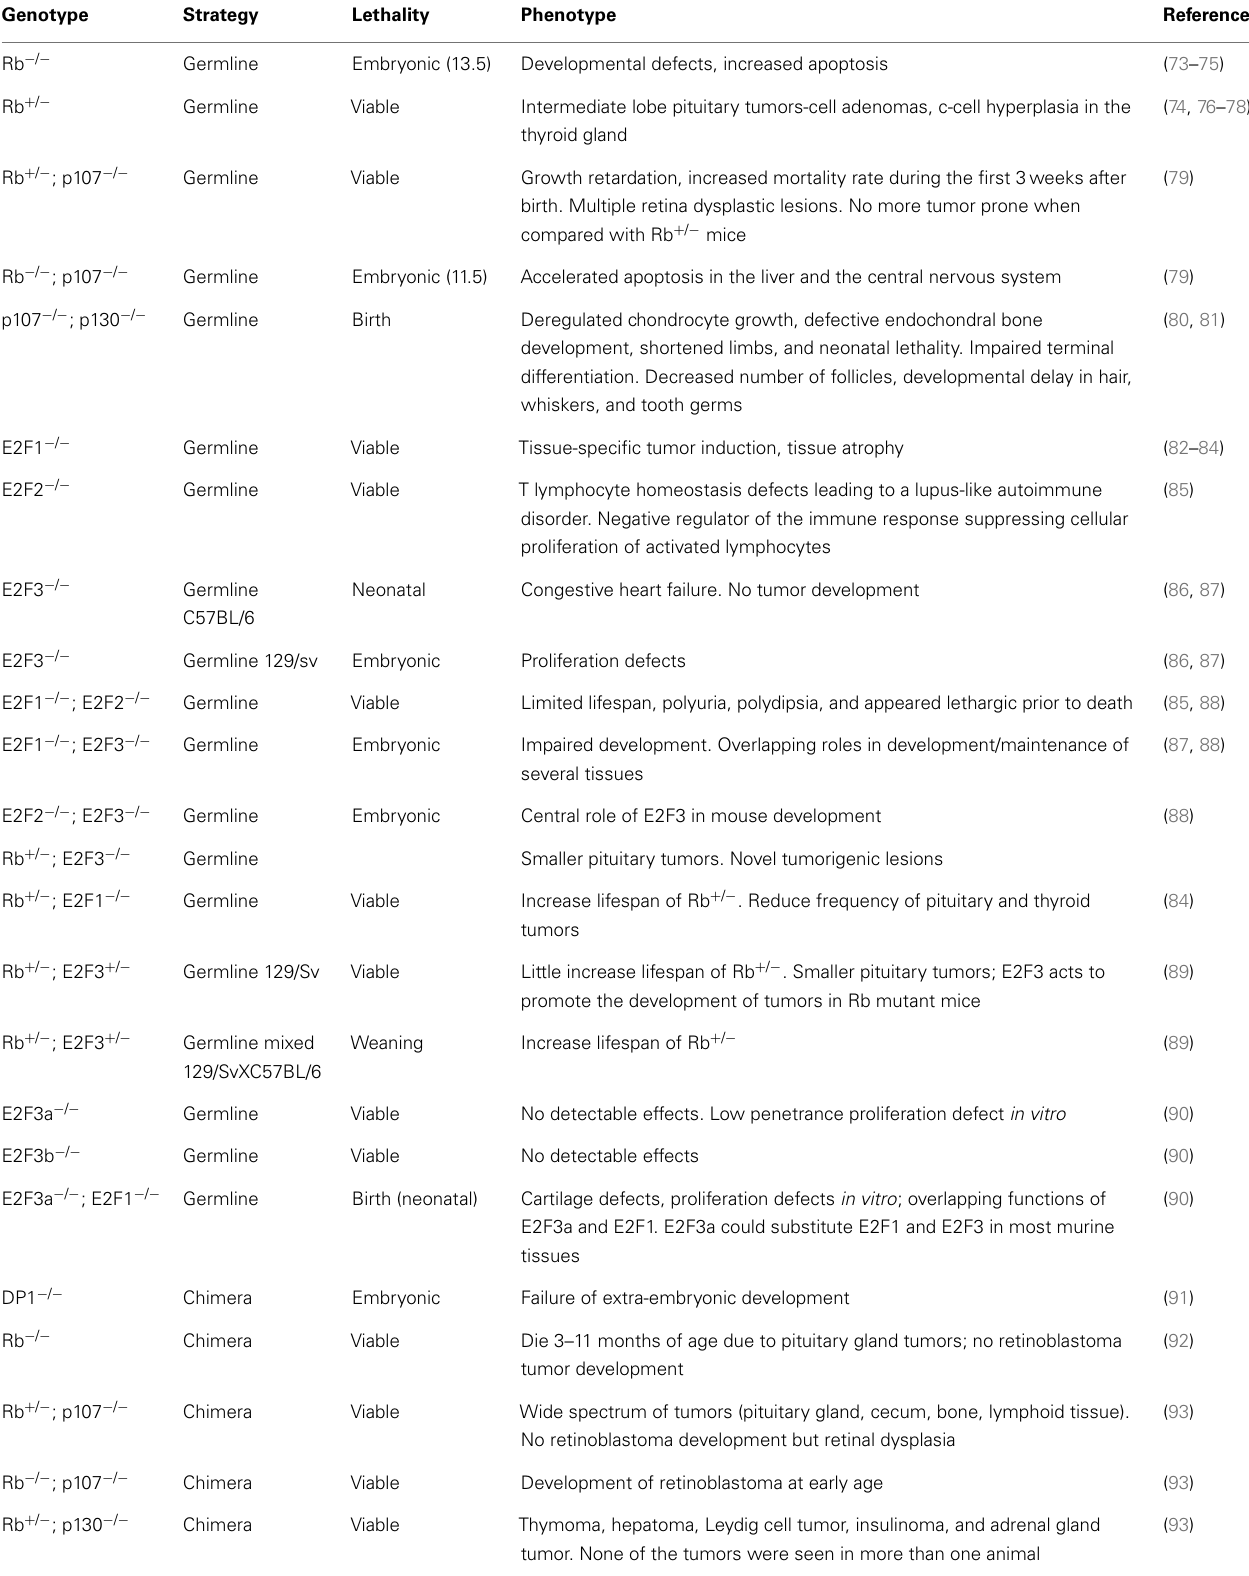
Table 1 | Phenotypic abnormalities observed in germline-ablated mouse models affecting retinoblastoma family members